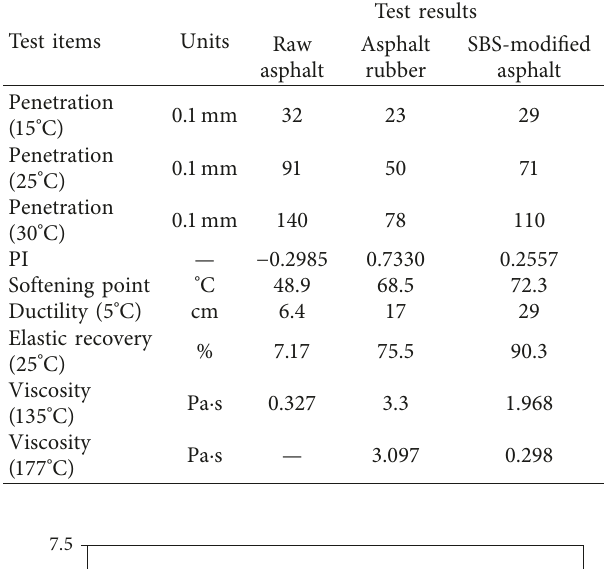
Table 7: Conventional properties of asphalt.